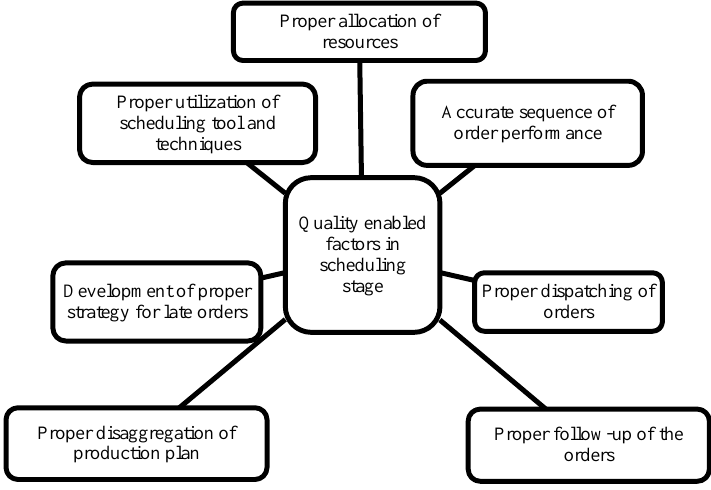
Fig. 1. Quality enabled factors in scheduling system